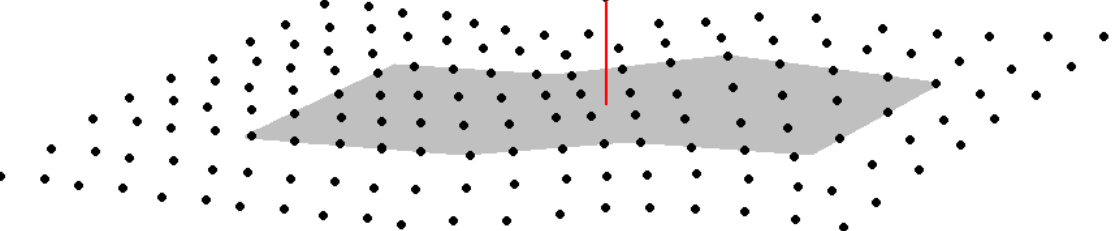
Figure 4. Polynomial surface patch in the immediate neighborhood of the point being